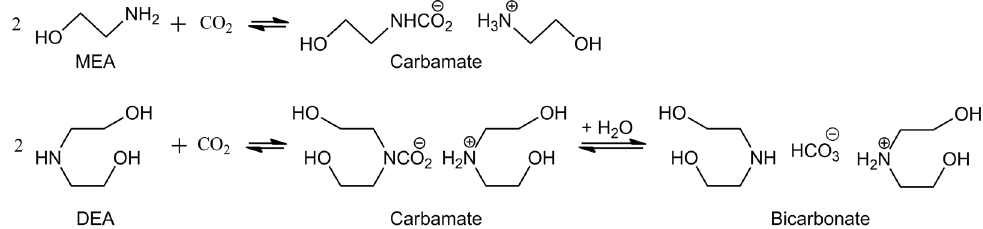
Figure 16. Capture of CO 2 by MEA or DEA, forming carbamate and bicarbonate, respectively.